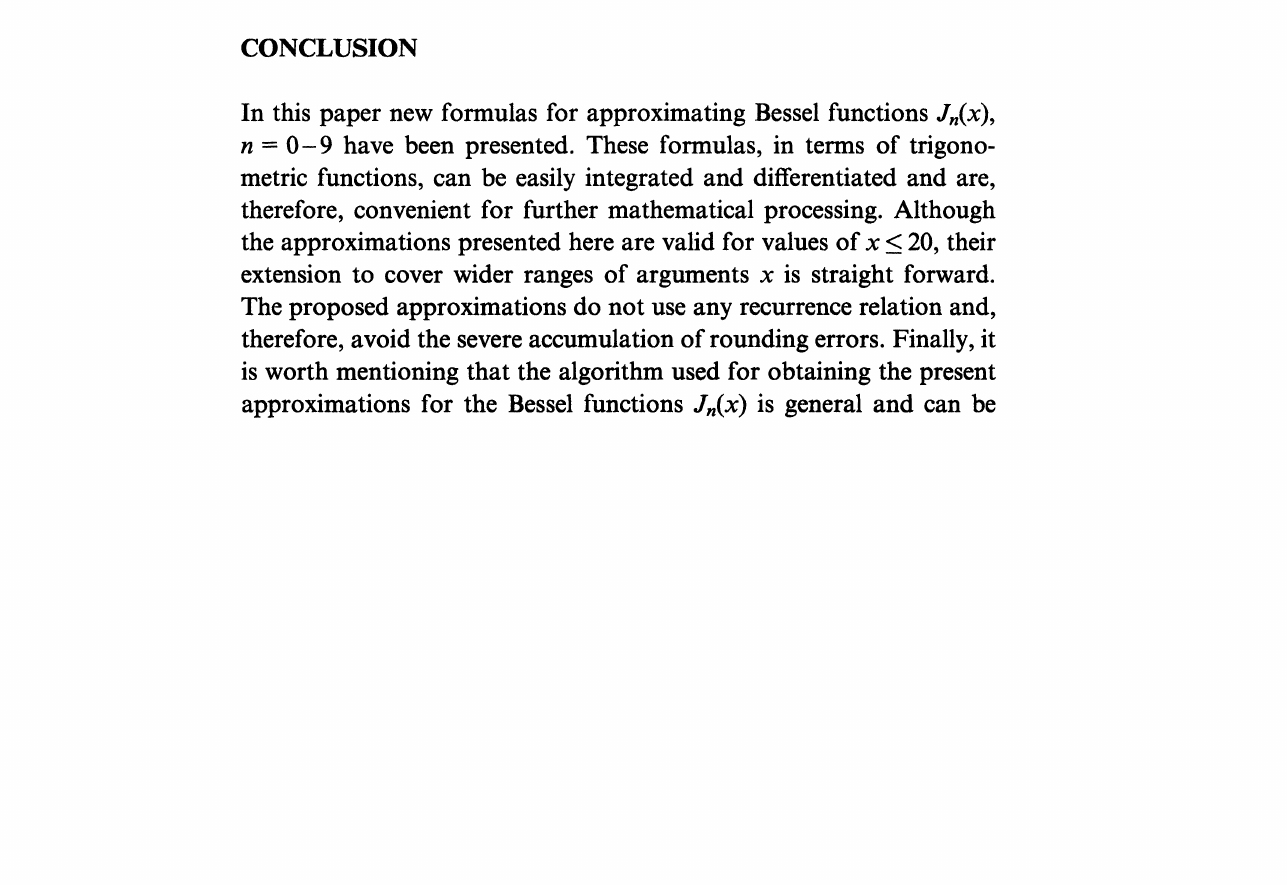
TABLE XII Parameters a,,m of the Bessel function